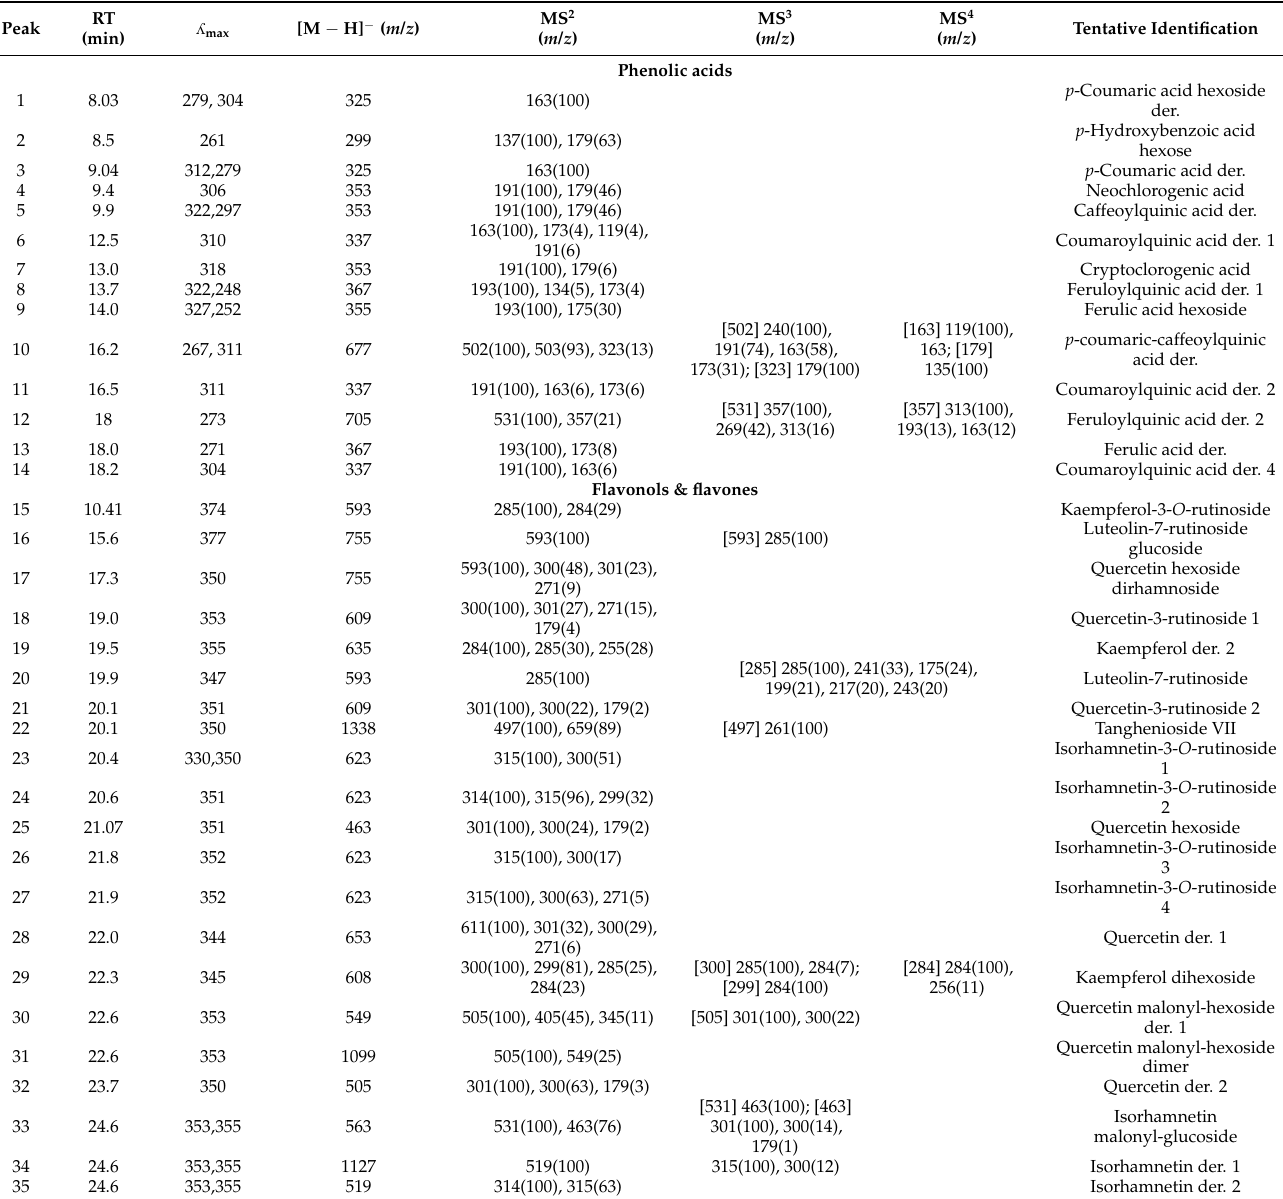
Table 4. Tentative identification of phenolic acids, flavones and flavonols from Slovenian populations of Phyteuma , indicating molecular mass-to-charge ratio ( m / z ) and relative intensity between